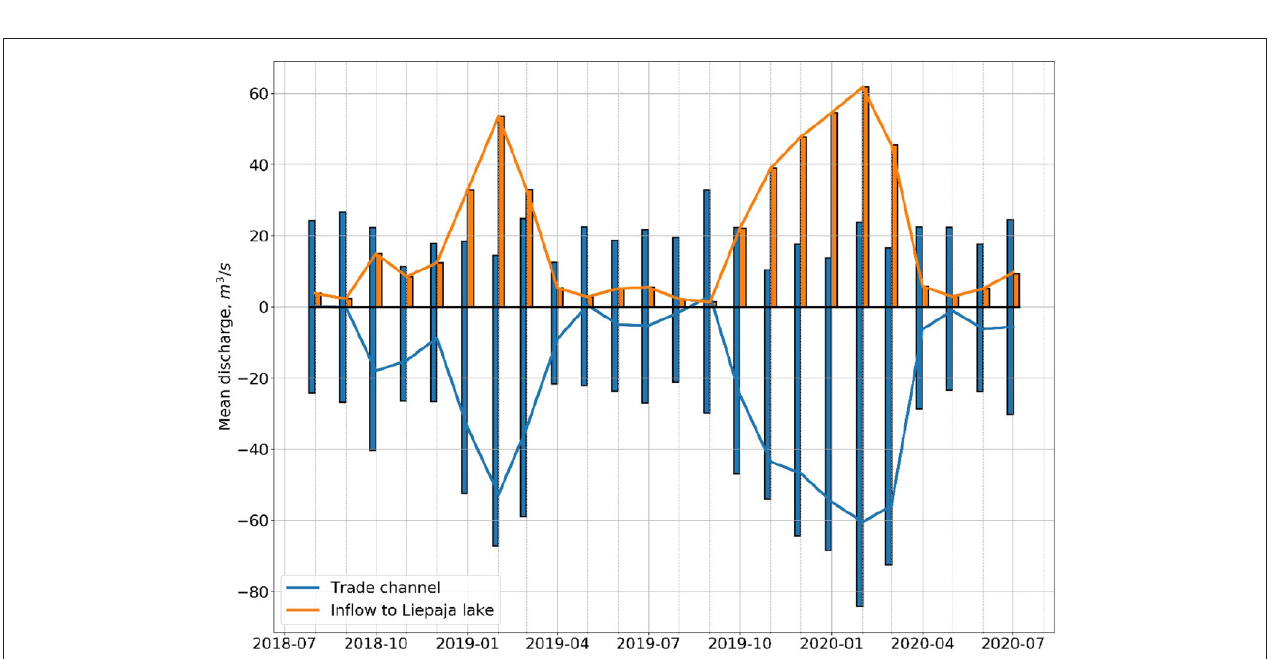
FIGURE 7 | Calculated monthly mean discharge through cross-sections on the boundaries of Liepaja lake area. Positive discharge is into the lake, negative discharge is out of it. Mean positive, mean negative (bars), and mean total (lines) discharge for each of the cross-sections is shown.